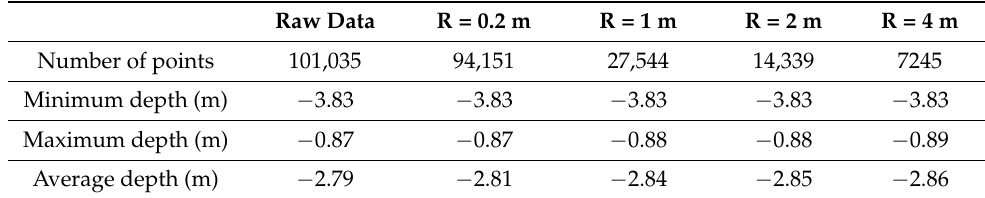
Table 3. The reduction results for SBES data.